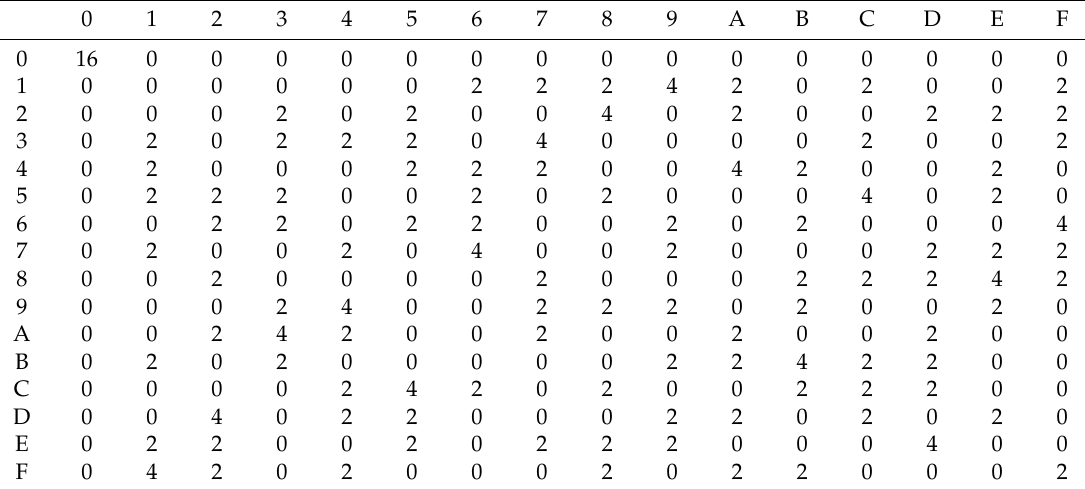
Table 6. Difference distribution table of the proposed